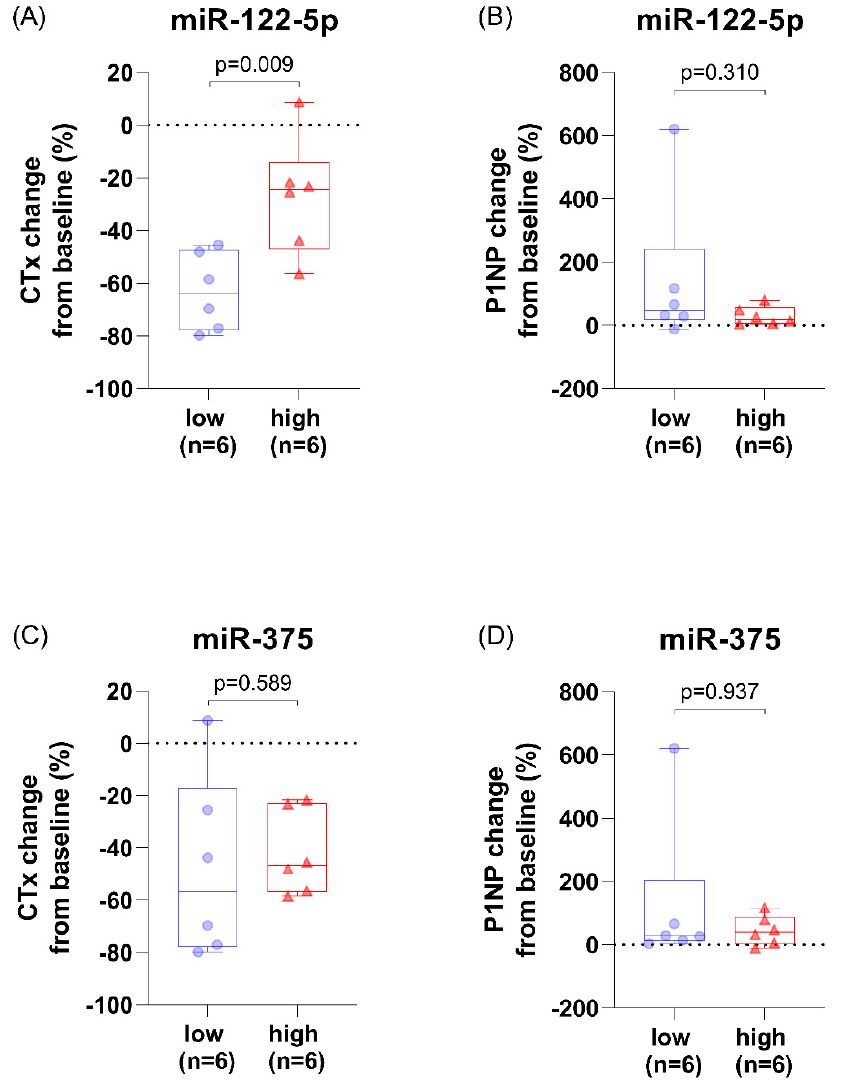
Figure 2. Change in bone turnover markers from baseline (%), 2 weeks after parathyroidectomy, with respect to miR-122-5p and miR-375 levels in patients with PHPT. ( A ) The postoperative CTx change (%) with respect to miR-122-5p levels. ( B ) The postoperative P1NP change (%) with respect to miR-122-5p levels. ( C ) The postoperative CTx change (%) with respect to miR-375 levels. ( D ) The postoperative P1NP change (%) with respect to miR-375 levels. Abbreviations: C-terminal telopeptide of type 1 collagen (CTX) and procollagen type 1 N propeptide (P1NP).